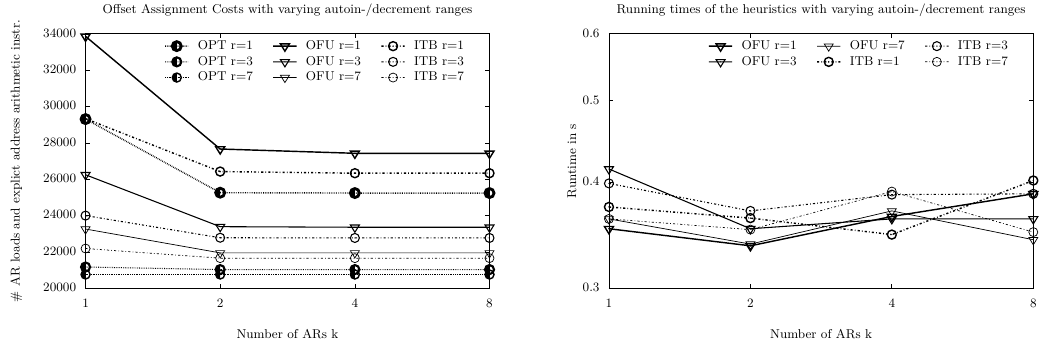
Figure 9 Offset assignment costs for all tested configurations and running times of the